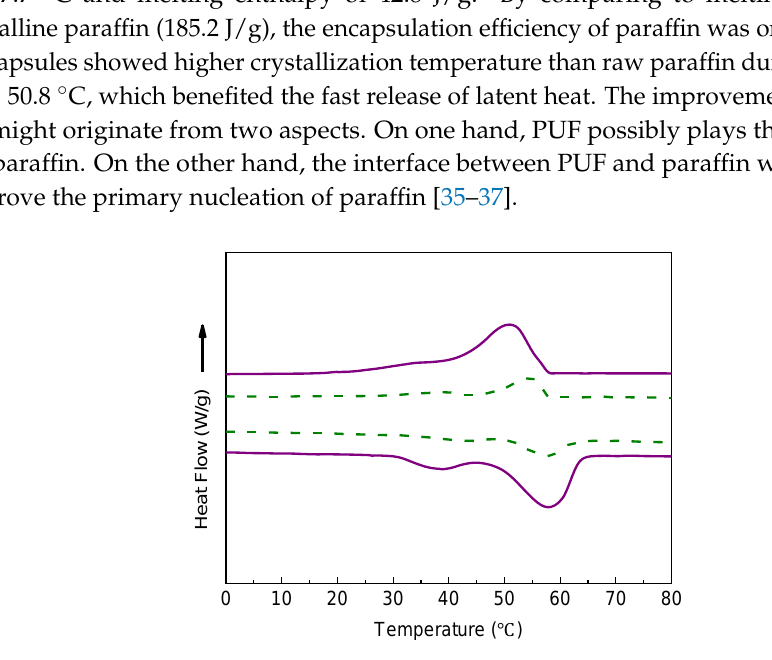
Figure 1. Differential scanning calorimetry (DSC) heating and cooling curves of paraffin (solid line) and microcapsules prepared without sodium chloride and crosslinker (dash line).